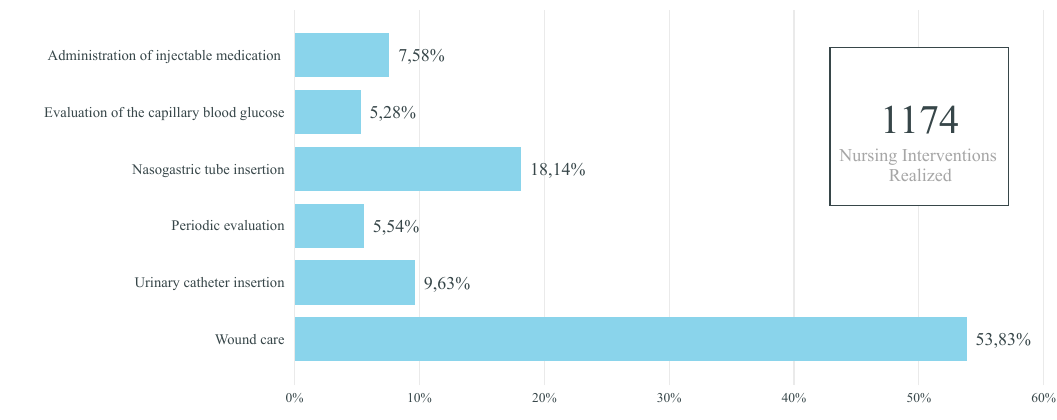
Figure 5. Indicator of the percentage of nursing interventions realized annually per type of nursing intervention (created with fictitious data).